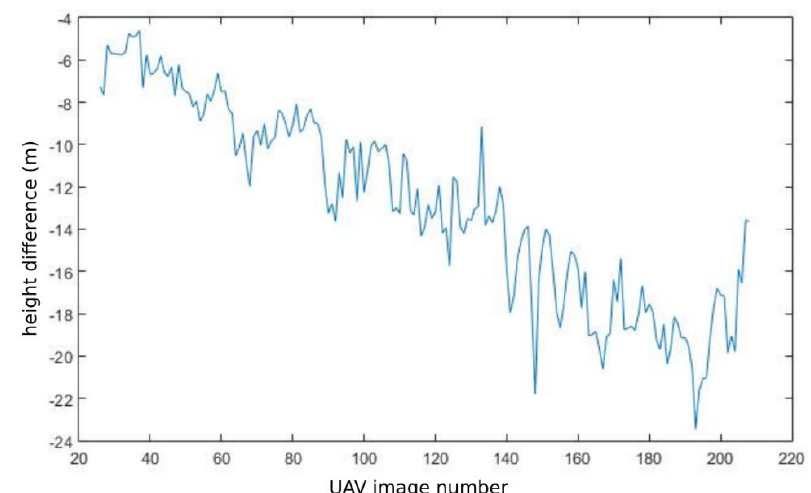
Figure 13. Differences of the barometric heights and the actual heights above take-off (ATO). The Figure 13. Di ff erences of the barometric heights and the actual heights above take-o ff (ATO). The values in the figure are calculated as the barometric heights subtracted by the PC's heights ATO.